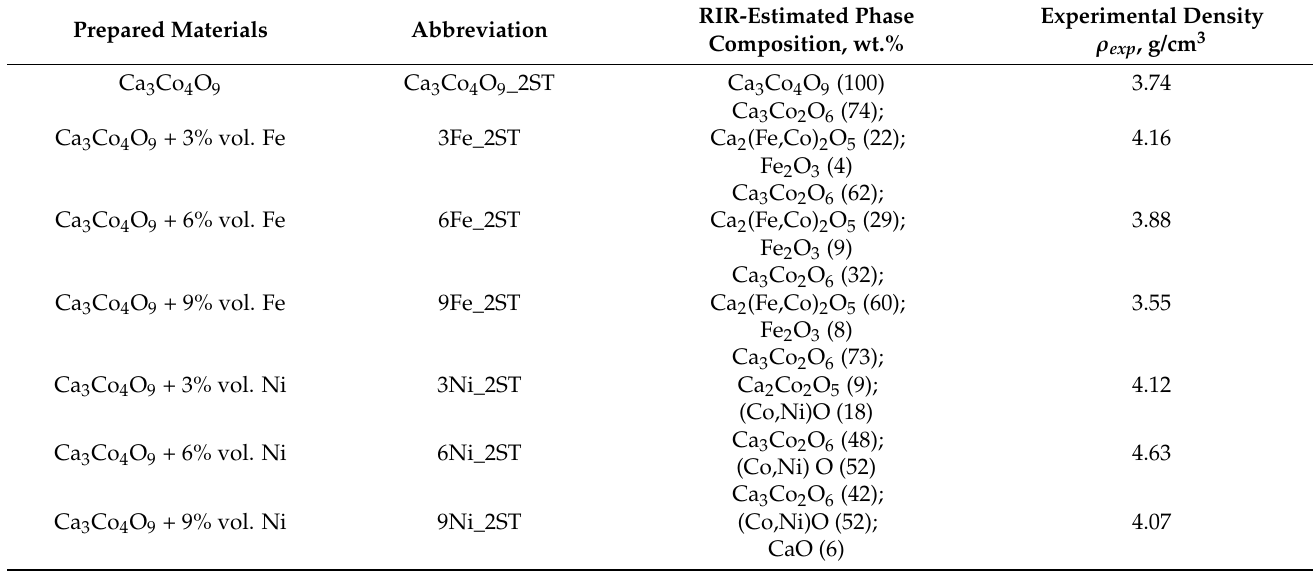
Table 2. Abbreviations, phase composition, and relative densities for all two-stage (2ST) sintered samples.